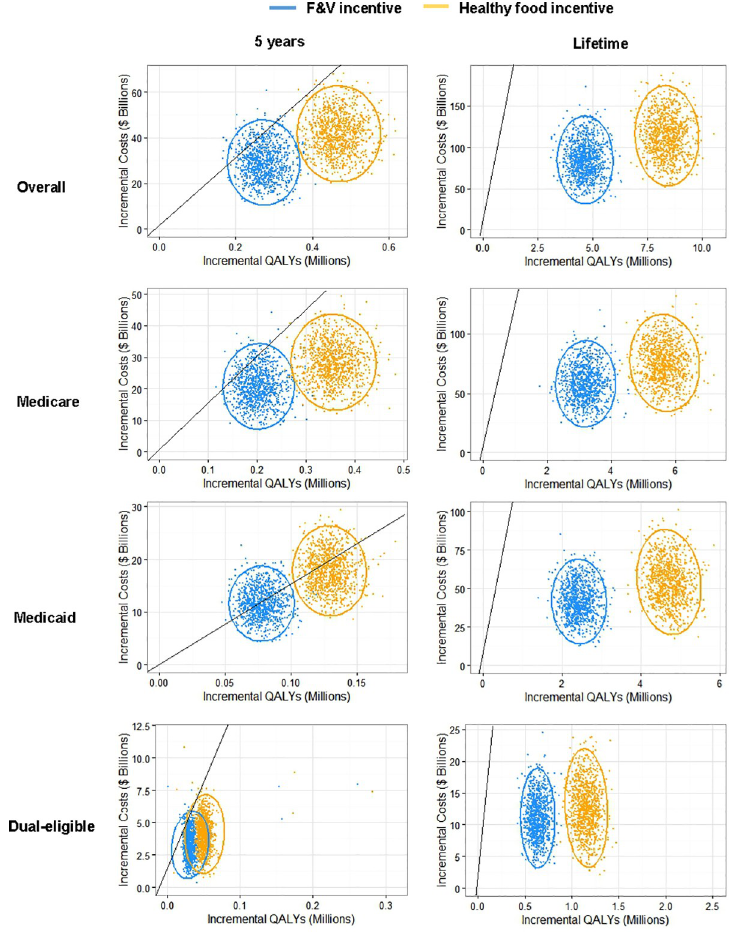
Fig 3. Probabilistic sensitivity analyses for cost-effectiveness of the F&V incentive and healthy food incentive programs through Medicare and Medicaid, by insurance group at 5 years and over a lifetime from a healthcare perspective. Values are presented in cost-effective planes of incremental costs ($ billions) versus incremental QALYs, compared to a base scenario of usual care. For each scenario, each colored dot depicts 1 of 1,000 Monte Carlo iterations, and the ellipse depicts the 95% UIs. Results are presented from the healthcare perspective. The solid black lines represent a value of $150,000/QALY, a recommended threshold for assessing health interventions, with values to the right of the line being cost-effective with an ICER < $150,000/QALY. Note: Because of the different population sizes of each beneficiary group, different axis scales were utilized for each panel. F&V, fruits and vegetables; ICER, incremental cost-effectiveness ratio; QALY, quality-adjusted life year; UI, uncertainty